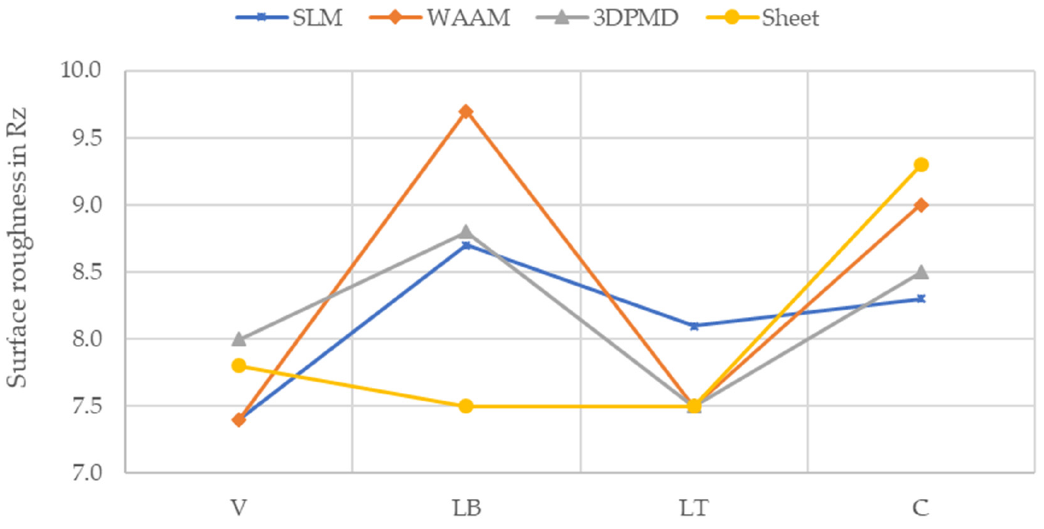
Figure 15. Chips of the milling process of ( a ) SLM, ( b ) WAAM, ( c ) 3DPMD, ( d ) sheet metal.